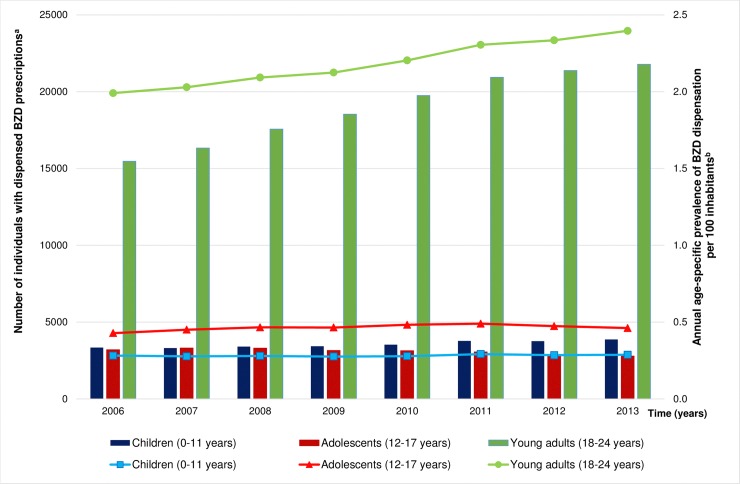
Individuals with dispensed BZD prescriptions by year and the annual age-specific prevalence of dispensations.Relative change in prevalence of BZD dispensation in 2013 from that in 2006 (the value estimated in 2006 is subtracted from that in 2013, and the result is divided by the value in 2006; reported as a percentage, with positive quantities corresponding to increases in values over time): in children +3.5%, in adolescents +6.9%, and in young adults +20.1%. aBars denote the absolute number of individuals who were dispensed at least 1 BZD prescription in a given year. bLines denote the annual age-specific prevalence rate of BZD dispensation among the Swedish inhabitants (prevalence rates are adjusted for population growth in the given age groups based on data from Statistics Sweden). BZD, benzodiazepine or benzodiazepine-related drug.